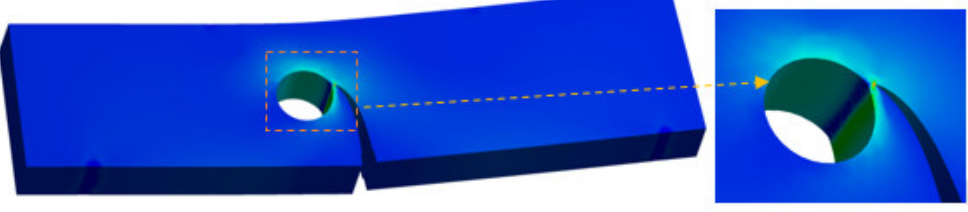
Figure 6. Maximum principal stress distribution.